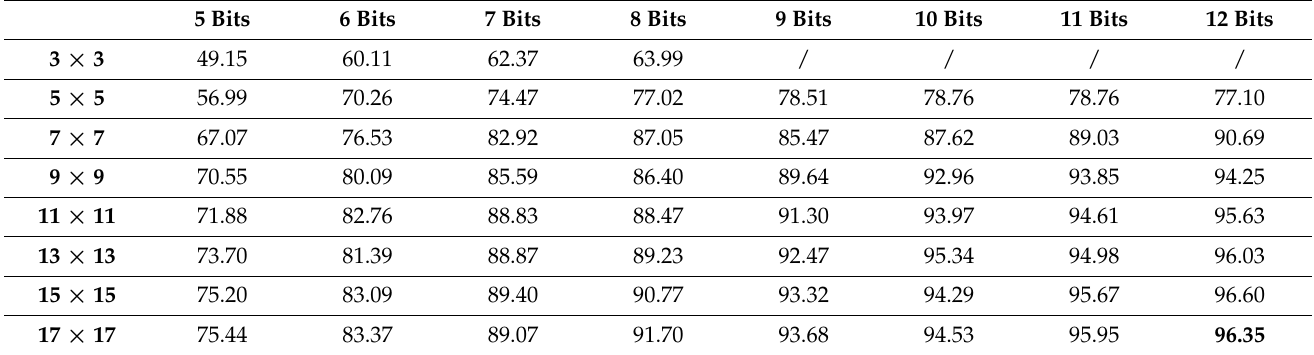
Table 2. Identification accuracies using all BSIF parameters applied to the CASIA database.